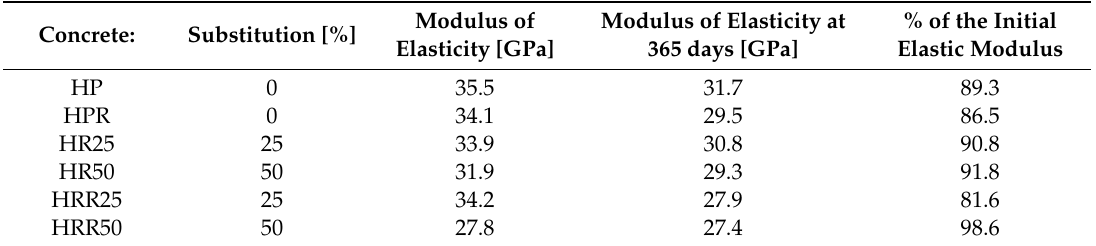
Table 4. Modulus of